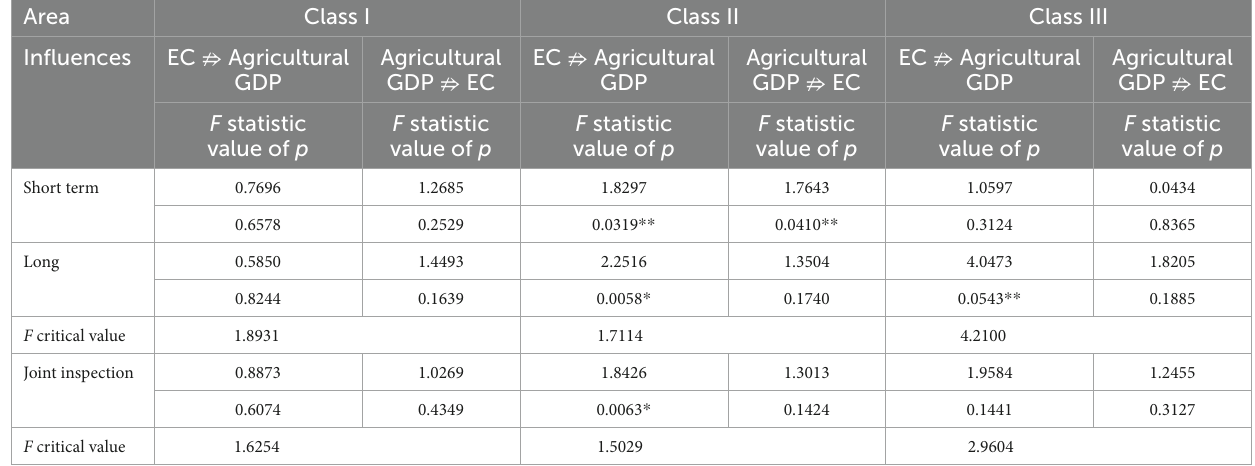
TABLE 11 Test results of the influence of energy consumption on economic growth among three regions.